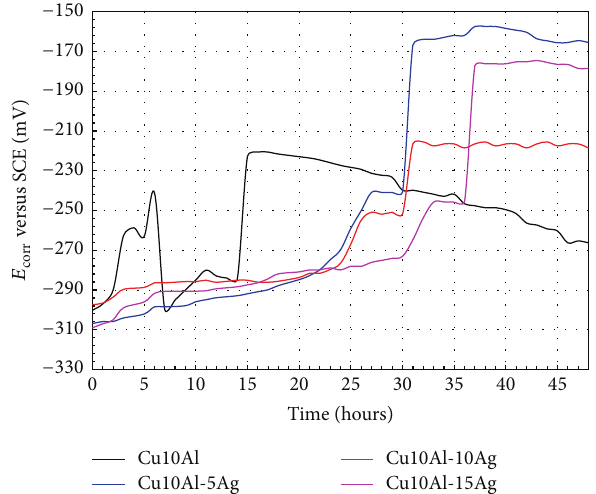
Figure 6: 𝐸 corr values after testing time for Cu10Al- 𝑥 Ag alloys in artificial saliva at 37 ∘ C.